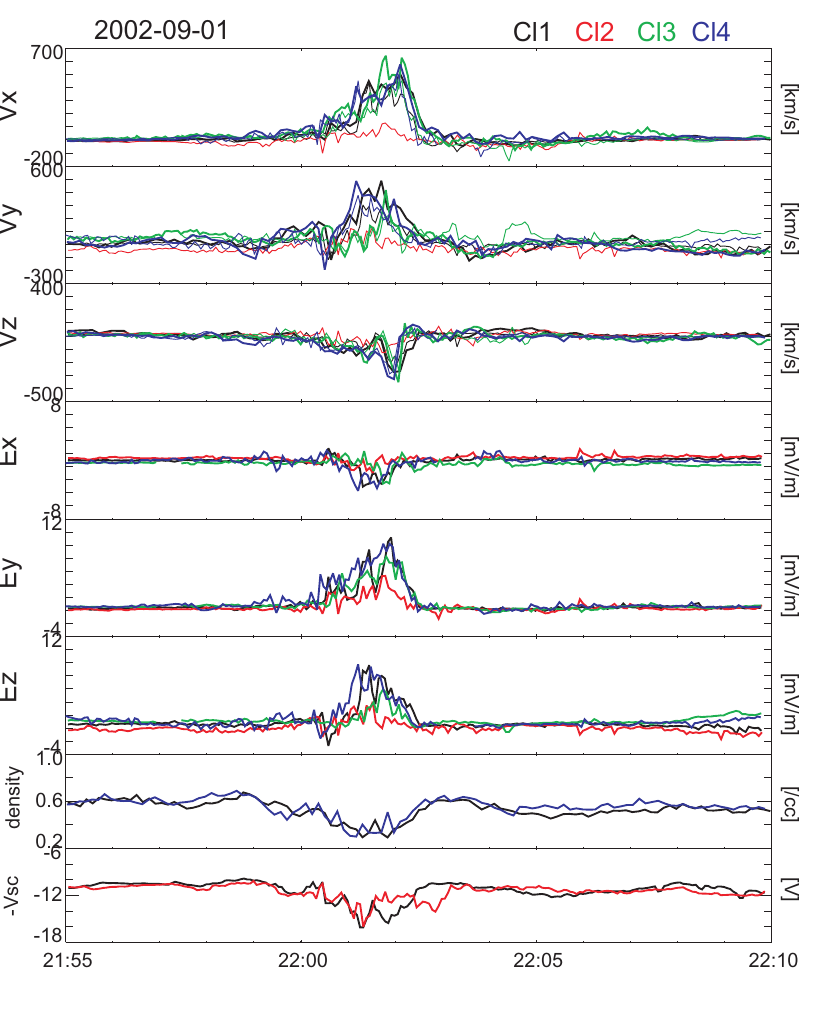
Fig. 4. CIS and EFW observations of X , Y , and Z component of the flow perpendicular to the magnetic field and the electric field, and density. The flow velocity obtained by the CIS instrument is shown as thick line, whereas E × B drift velocity obtained by the EFW and FGM measurements are shown as a thin line. The electric field data are plotted using the EFW measurement and the assumption of E · B = 0. The bottom two panels show the proton density from Clusters 1 and 4 and the negative value of the spacecraft potential from Clusters 1 and